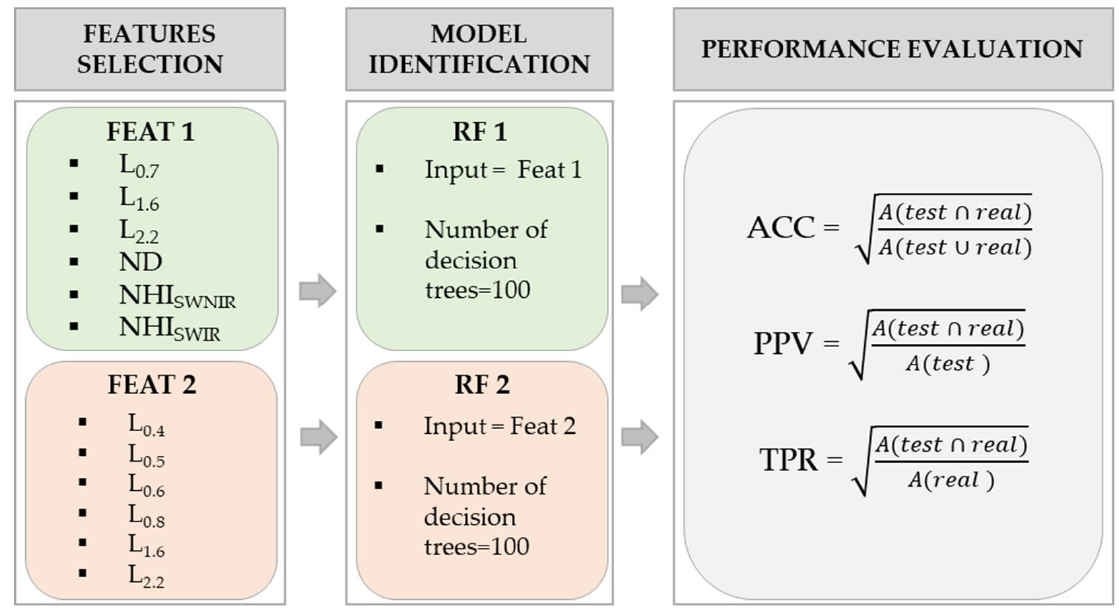
Figure 3. General workflow representing the three main steps of the ML algorithm: features selection, model identification, and performance evaluation.